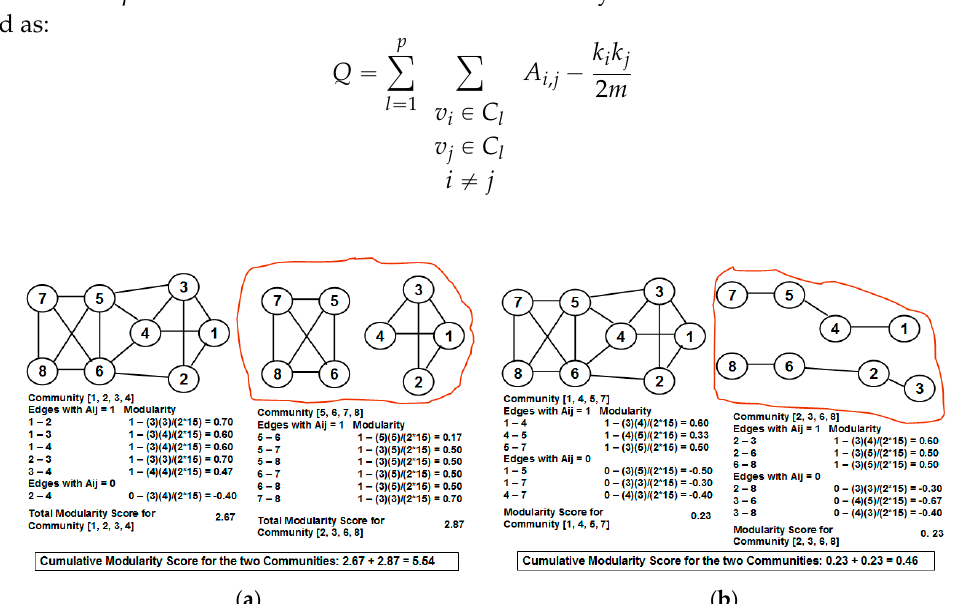
Figure 2. Example to illustrate the calculation of modularity scores of communities. ( a ) Partition with high cumulative modularity score; ( b ) Partition with low cumulative modularity score.